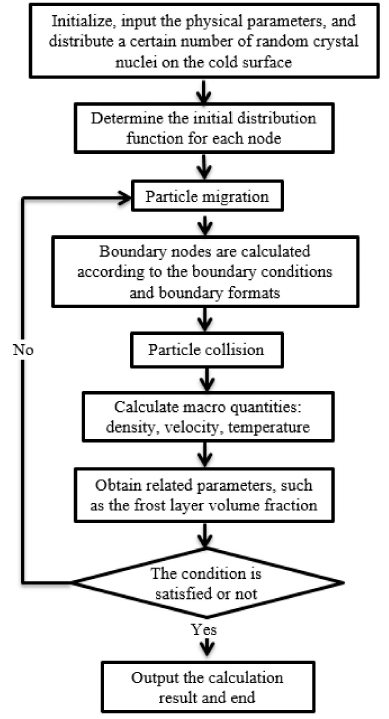
Figure 2. The flow chart of the Lattice-Boltzmann